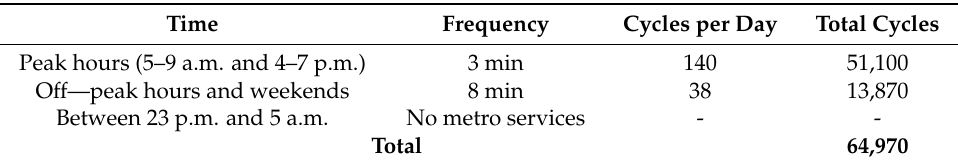
Table 6. Assumed train operation for a calendar year. Table 7. ESD total cost for a 10-year period.